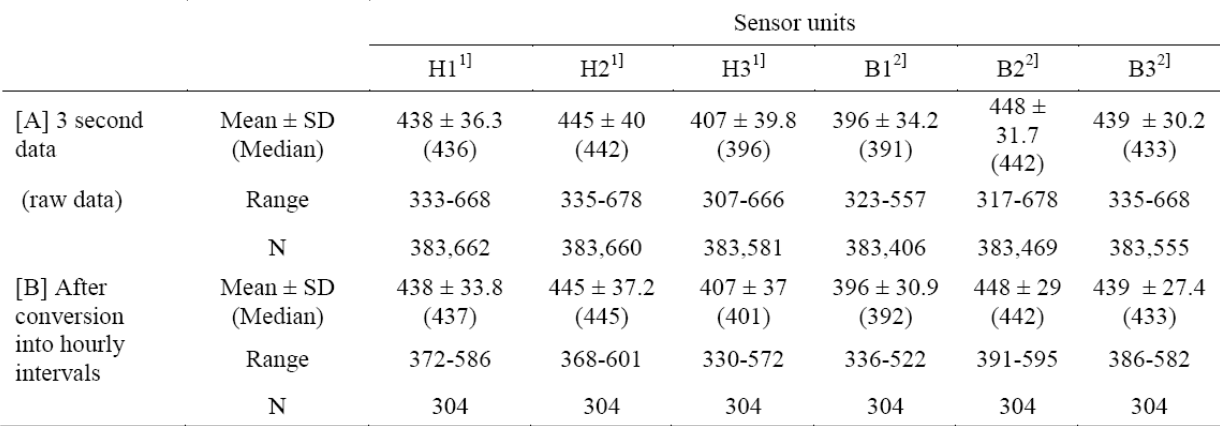
Table 2. A statistical summary of CO sensor types (H-500 and B-530